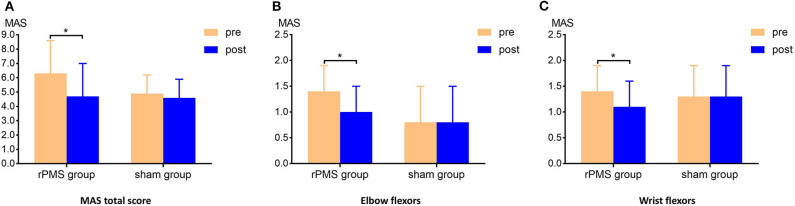
Clinical measurement of the MAS scores. (A) Comparison of the MAS total scores of the groups before and after the intervention. The MAS total score in the rPMS group differed significantly before and after the intervention; no difference was observed in the sham group. (B,C) Comparison of the MAS scores for the elbow flexors and wrist flexors for the groups before and after the interventions. Significant decreases were observed in the rPMS group, whereas no difference was noted in the sham group. *p < 0.0071, Bonferroni's correction.